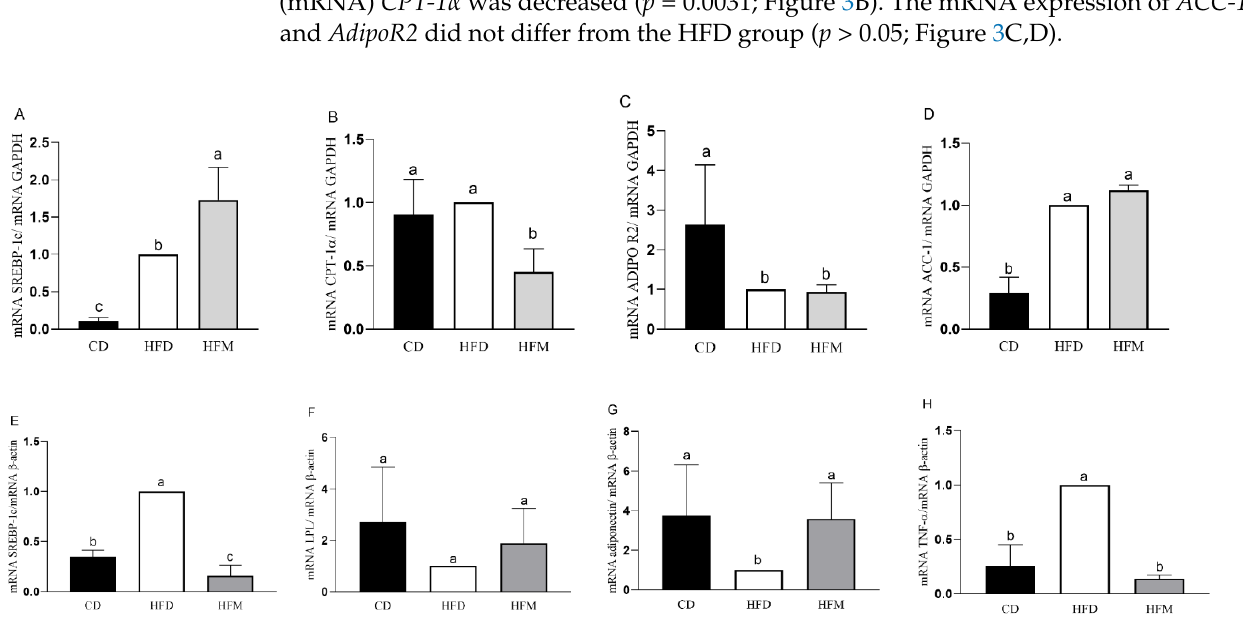
Figure 3. Gene expression in the liver ( A – D ) and adipose tissue ( E – H ) of mice after consuming the experimental diets for 8 weeks. Data are expressed as mean ± standard deviation ( n = 8). Different letters indicate a statistical difference based on the Newman–Keuls test ( p ≤ 0.05). CD: control diet —